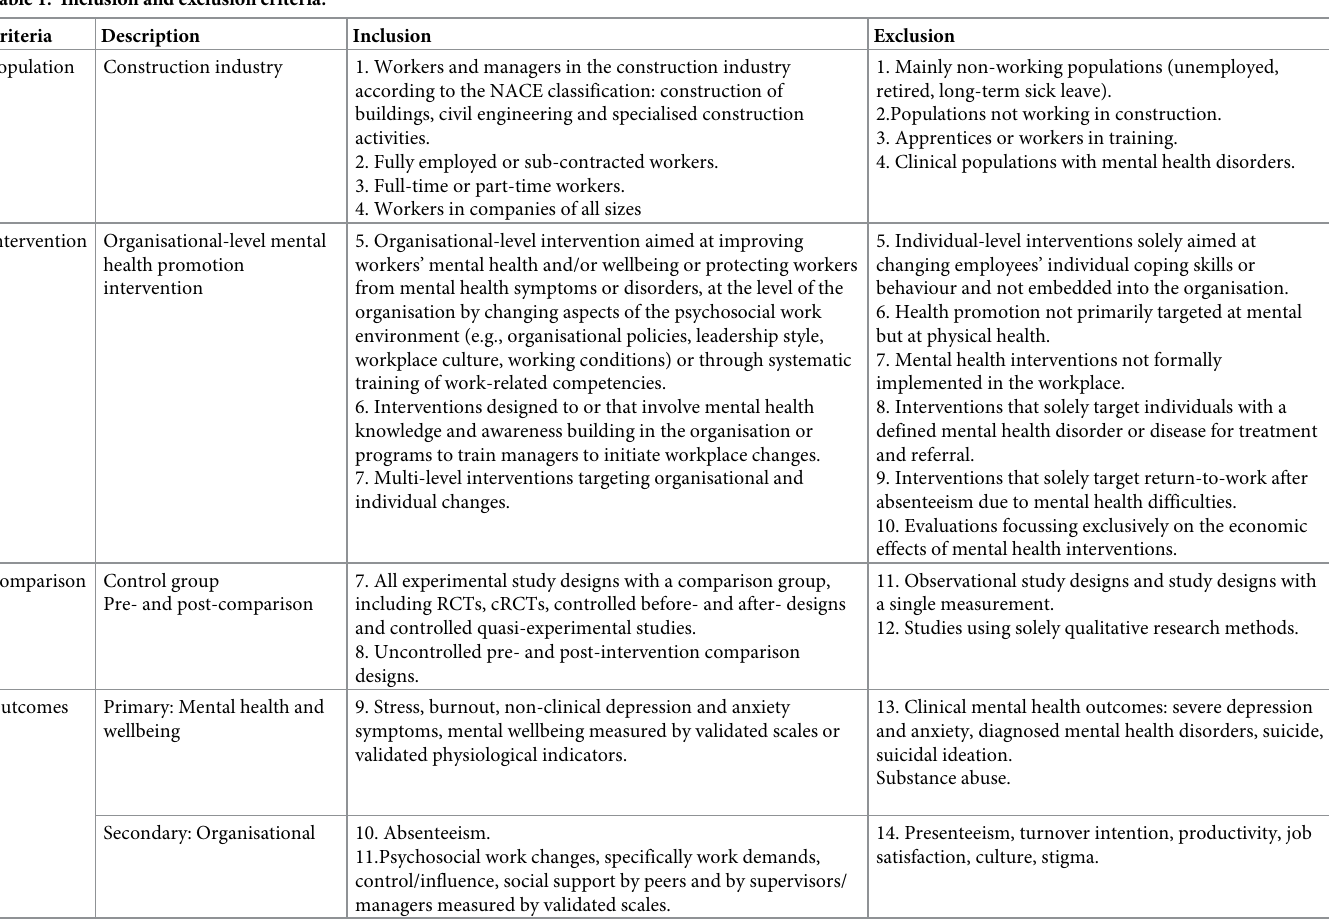
Table 1. Inclusion and exclusion